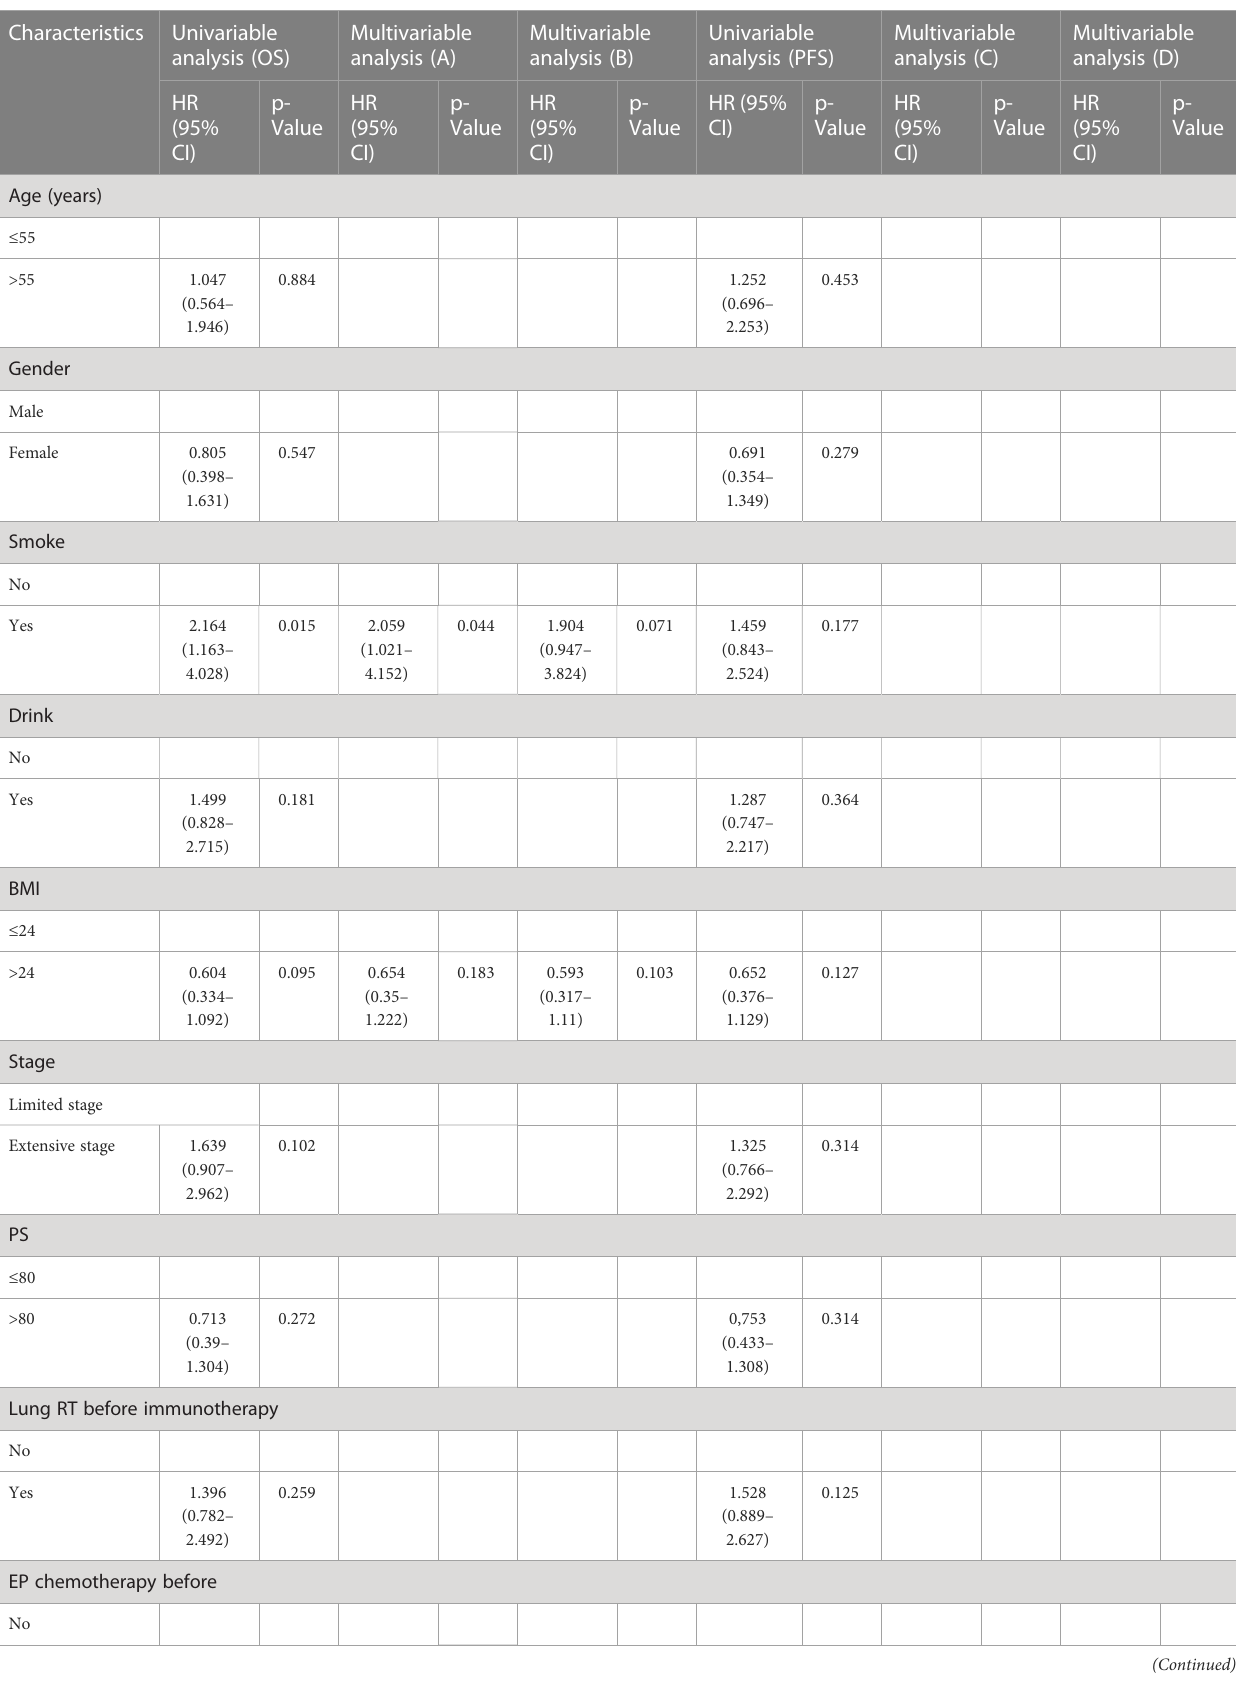
TABLE 4 Prognostic factors for overall survival and progression-free survival of the PSM cohort of SCLC